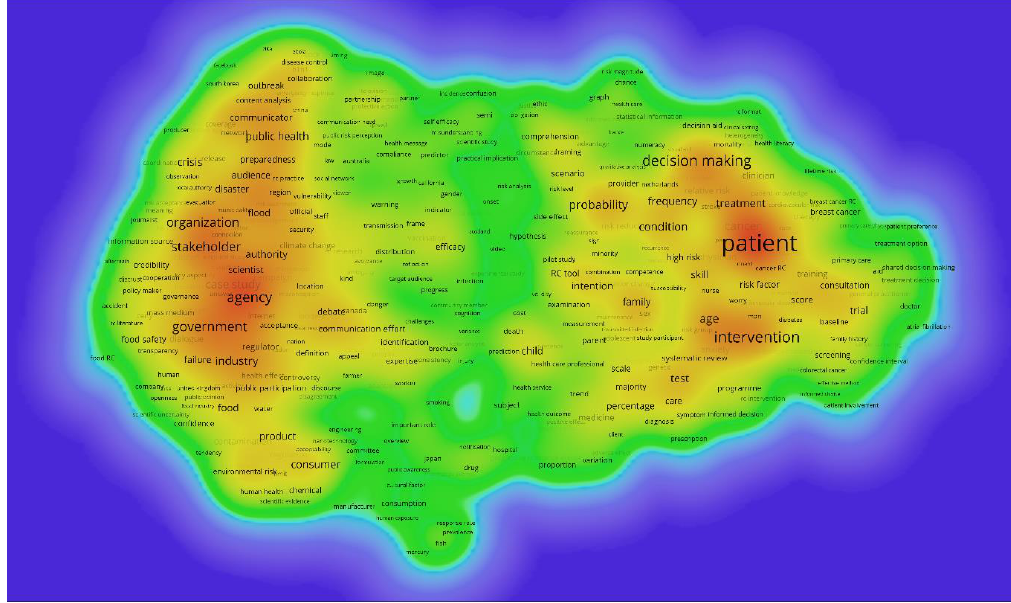
Figure 6. Term density map of risk communication research, all documents (458 terms included). Table 7. List of risk communication terms with more than 20 term occurrences.